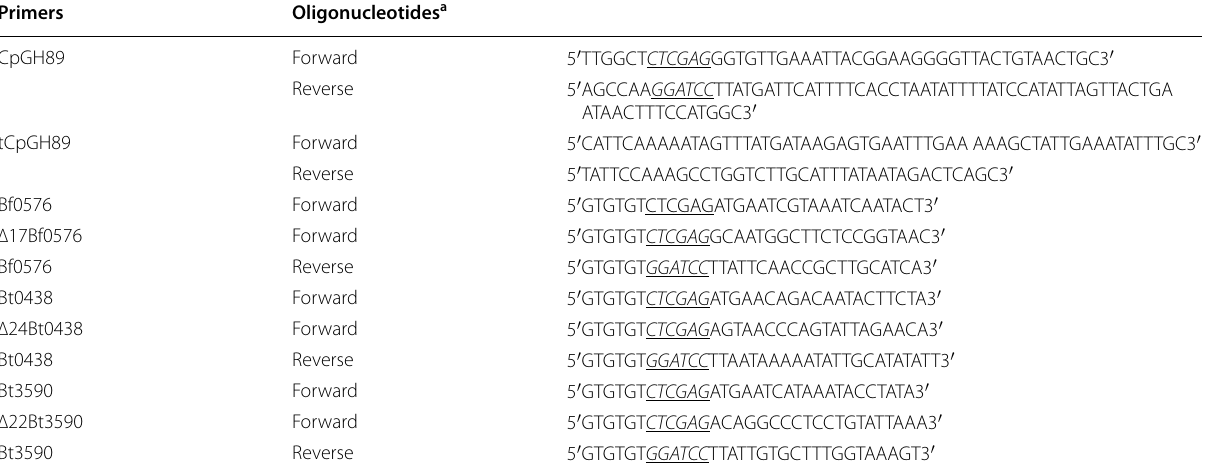
a Restriction sites are italicized and